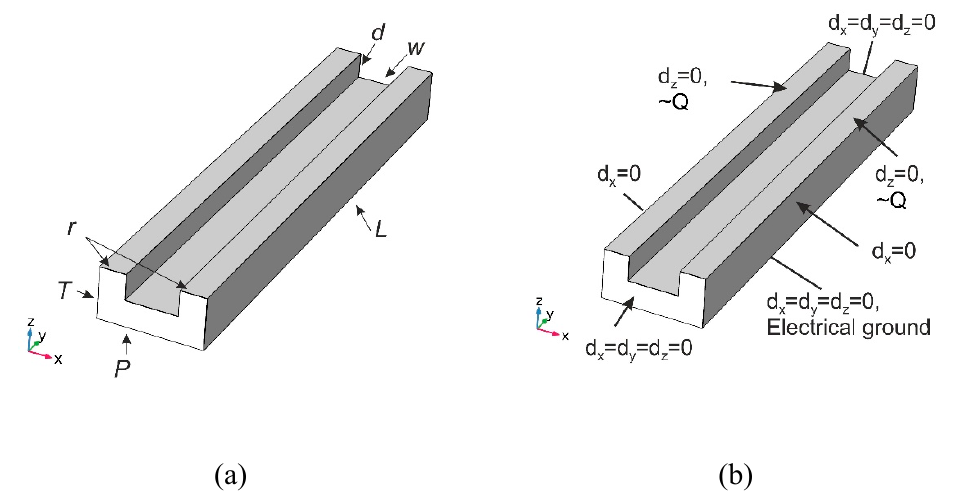
Figure 15. Dimensions ( a ) and boundary conditions ( b ) of the finite element model of microchannel.